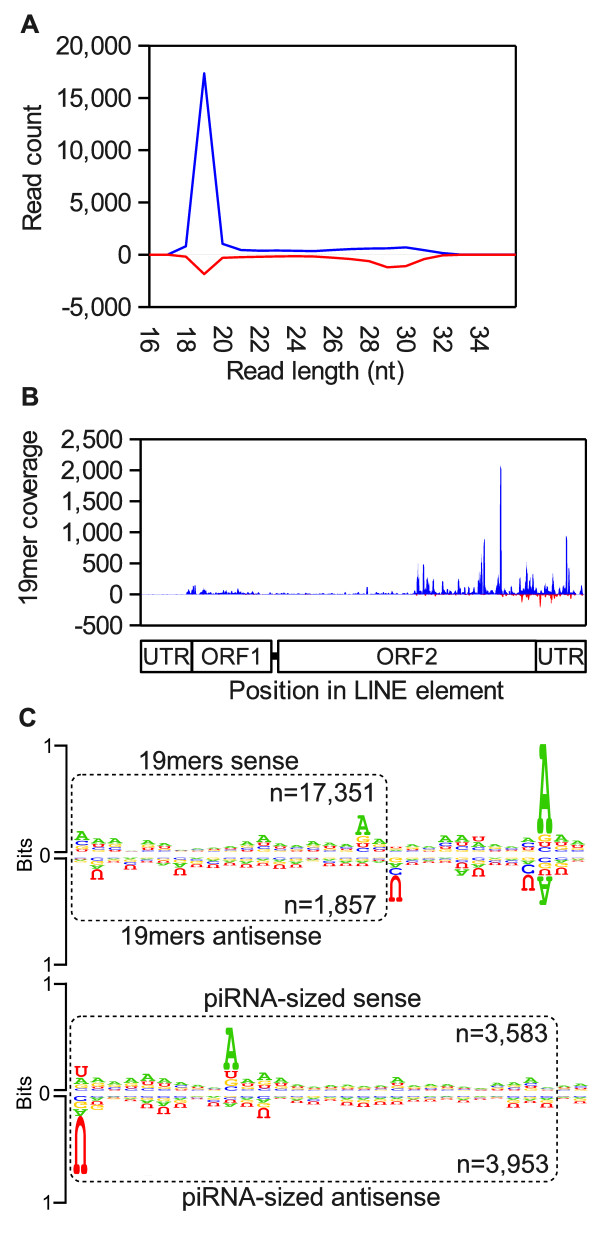
Distribution of small RNAs mapped to a LINE consensus sequence (A) The lengths of reads mapped to a LINE consensus sequence are presented. Reads mapped to the sense strand are presented above the x-axis, and reads mapped in antisense below (B) The coverage of 19mers across a 6.4 kb LINE consensus sequence is presented. Reads mapped to the sense strand are plotted above the x-axis, and reads mapped in antisense below. (C) The sequence composition of reads mapped to a LINE consensus sequence are presented. For each type of RNA the reads are separated according to their sense relative to the consensus sequence and plotted separately, as indicated. The sequence logos were extended beyond the 3' ends of the reads (unboxed regions) to reveal any downstream sequence bias.